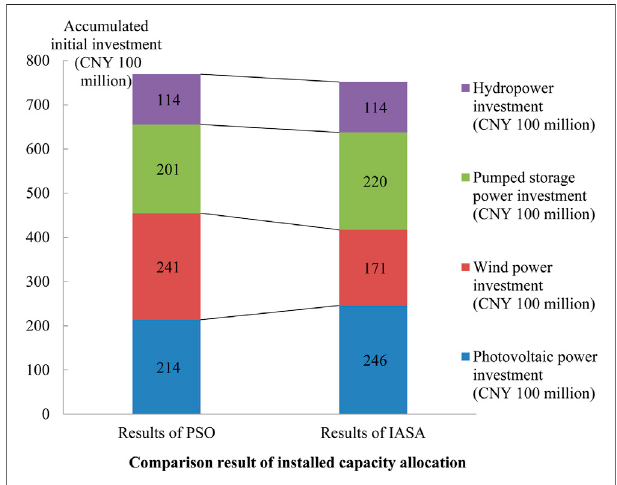
FIGURE 9 | Comparison of the installed capacity allocation schemes obtained by PSO and